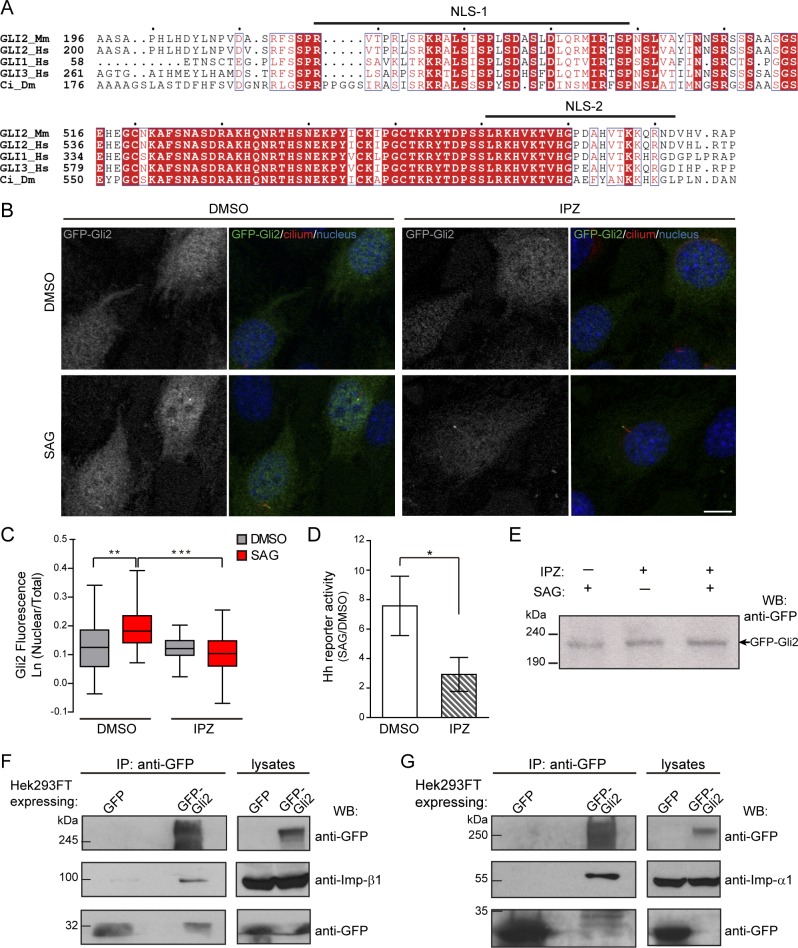
Imp-α/β1 transports Gli2 into the nucleus.(A) Two segments of a T-Coffee [69] alignment of four Gli-like sequences: GLI2_Mm (Mus musculus), GLI2_Hs, GLI1_Hs, GLI3_Hs (Homo sapiens) and Ci_Dm (Drosophila melanogaster). Residue similarity is colour coded according to the Risler substitution matrix, using ESPript [70]. Dots mark 10-residue intervals of the top sequence. Black bars indicate the two bipartite cNLS (cNLS-1 and cNLS-2) predicted by cNLS mapper [40] for GLI2_Mm. (B) GFP-Gli2-NIH/3T3 cells were treated with Importazol (IPZ) in order to inhibit Imp-β1-mediated nuclear transport. DMSO was used as control. Hh signalling was activated for 90 min using SAG and non-stimulated cells were treated with DMSO. Cells were stained for cilium (anti-Ac.Tub, red), GFP-Gli2 (anti-GFP, green) and nucleus (TOPRO, blue). The same pictures are also shown with the channel corresponding to GFP-Gli2 in grey scale to help the visualization. Scale bar: 10 μm. (C) Quantification of nuclear Gli2 was performed as explained in Materials and Methods. The mean nuclear fluorescence was normalised against the mean total GFP fluorescence of the cell, so as to correct for variations in Gli2 expression among different cells. Results are representative of three experiments and at least 60 cells were analysed for each condition. ** p<0.001, *** p<0.0001 (Kruskal-Wallis test). (D) Activation of a luciferase-based Hh reporter gene in NIH/3T3 cells stimulated with SAG (or DMSO as control) in the presence of IPZ or DMSO. As explained in Materials and Methods, RLU values from SAG treated cells are normalised against RLU of DMSO treated ones and expressed as mean ± s.d. from triplicates from two independent experiments. * p< 0.01 (Mann-Whitney test). (E) Western blot (WB) showing GFP-Gli2 levels in control and IPZ-treated cells. GFP-Gli2 was detected using an anti-GFP antibody. (F-G) WB detecting Imp-β1 (F) and Imp-α1 (G) after precipitating GFP-Gli2 with GFP-Trap (left) from HEK293FT transfected with pEGFP-Gli2 (left panels). Membranes were cut at different levels so as to detect in the same samples the precipitated GFP-Gli2 and GFP (left panels). The levels of GFP-Gli2, Imp-β1, Imp-α and GFP in the lysates used for immunoprecipitation were assessed by WB and are shown in the right panels. The band corresponding to GFP looks distorted because the protein migrates with the dye front.